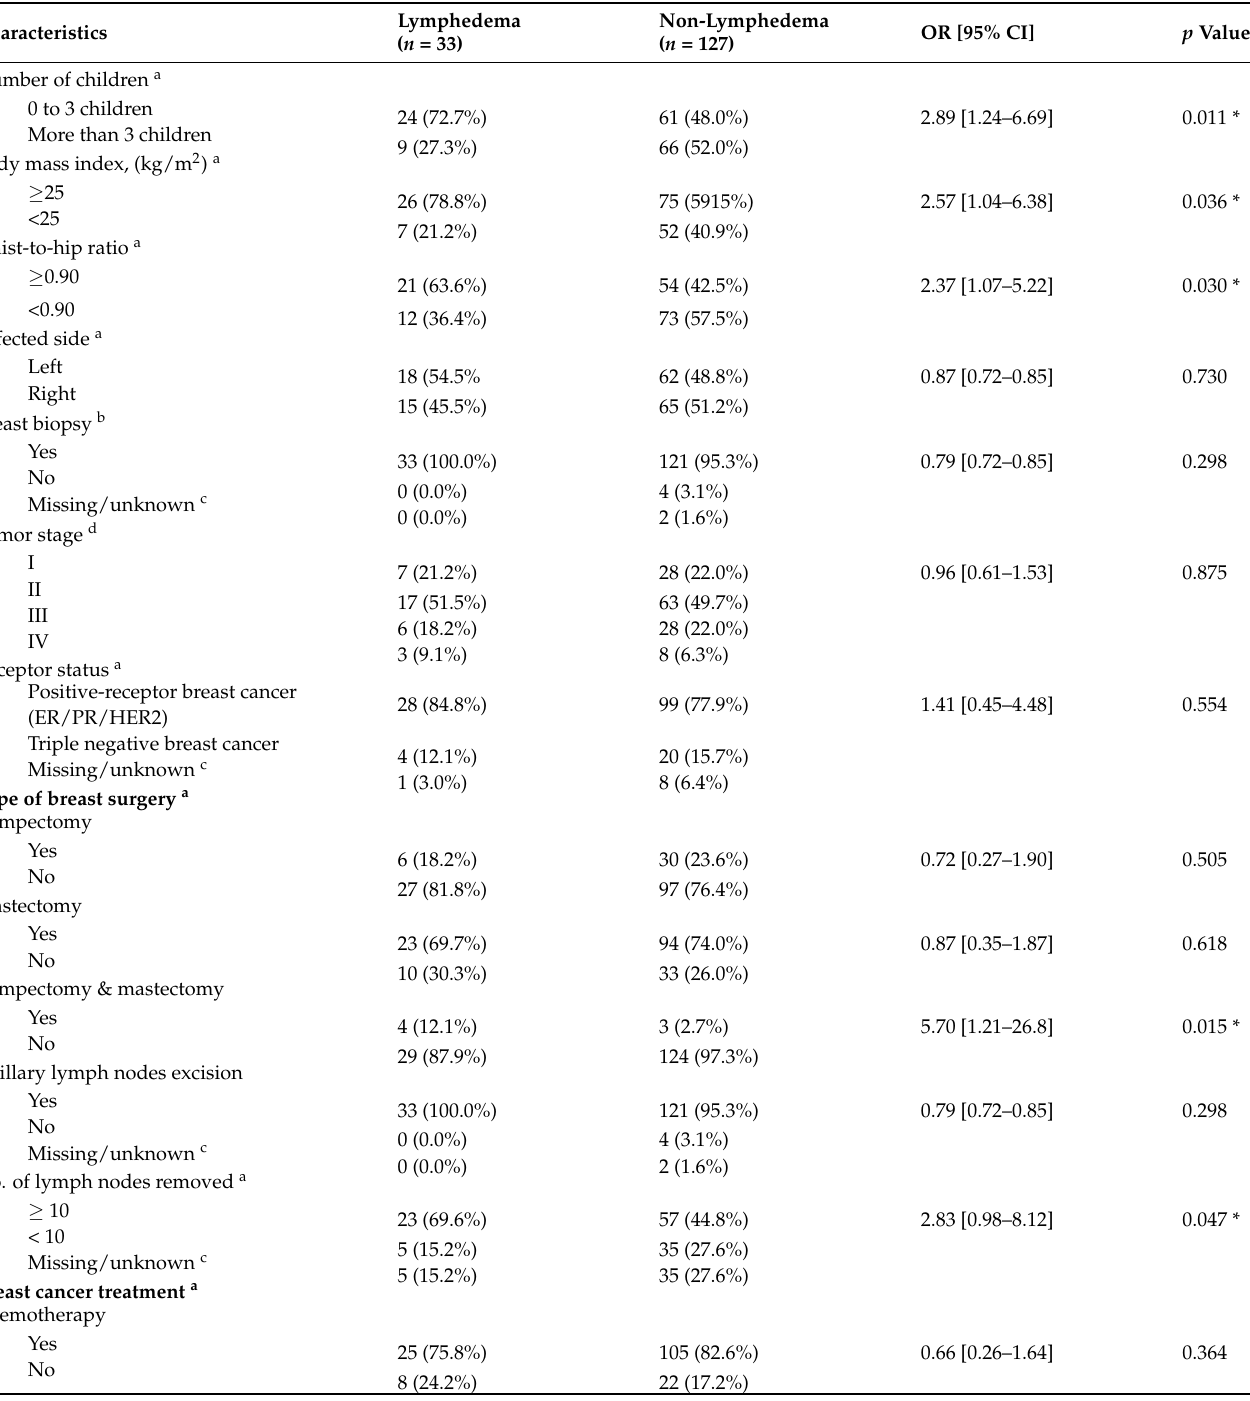
Table 3. Comparison of medical characteristics, treatment-related factors, and arm morbidities of the study population.